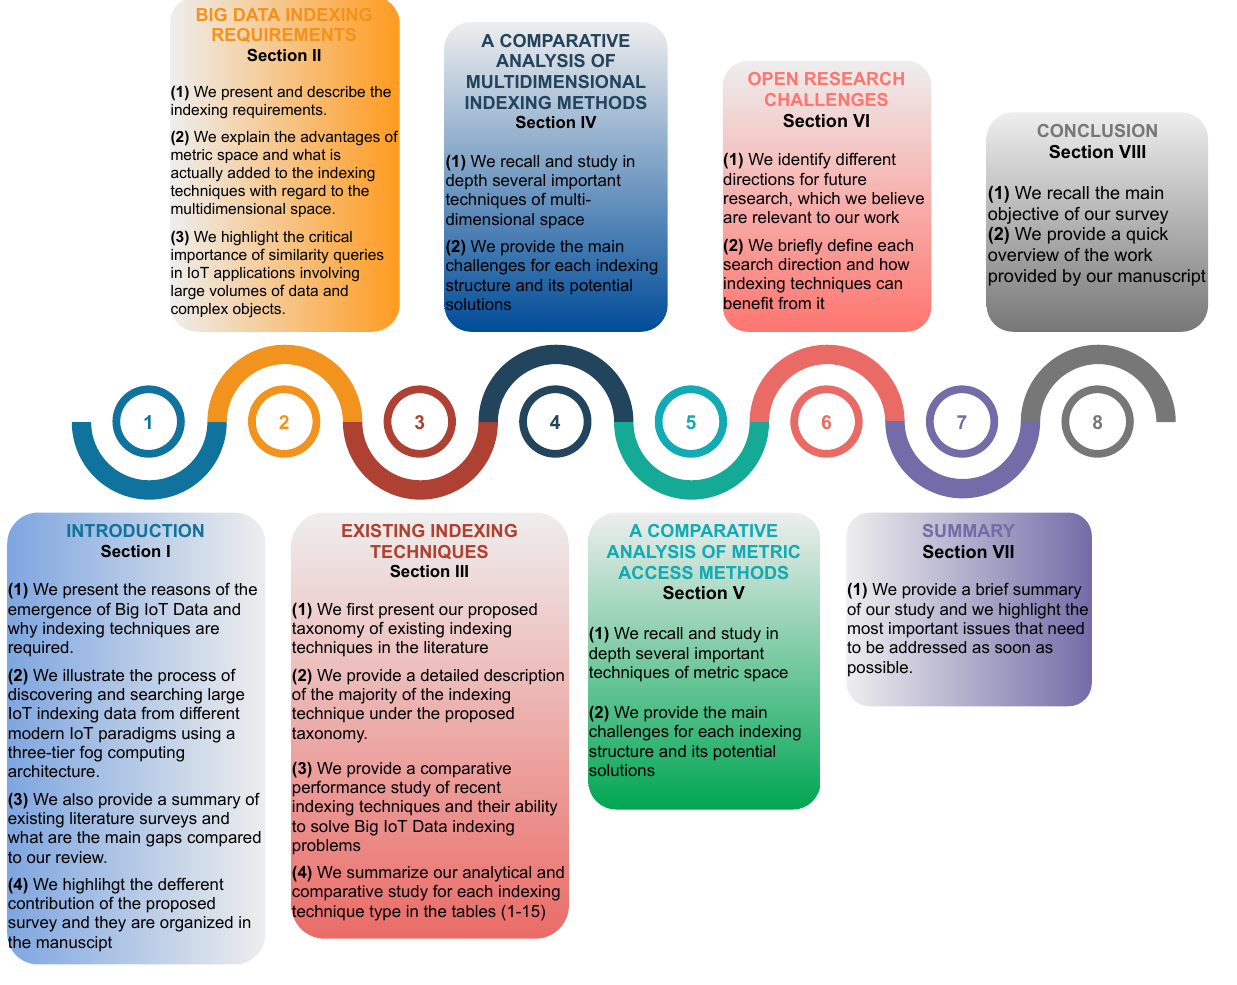
Figure 2. Organization of the survey.